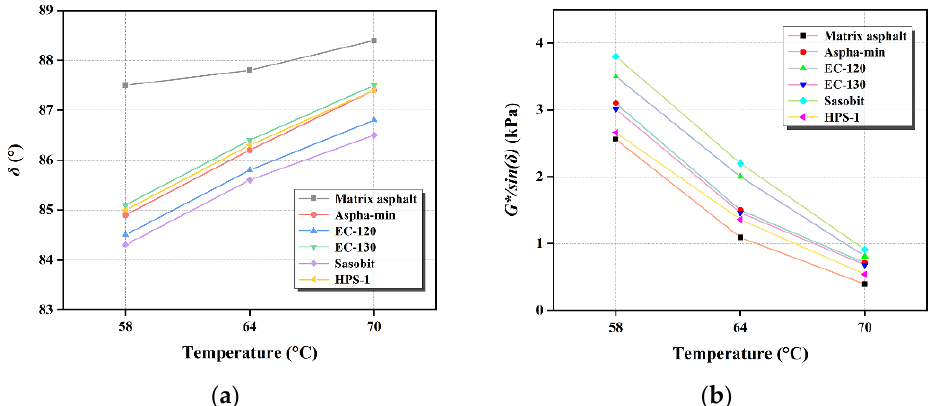
Figure 1. Test results of dynamic shear properties of original asphalt under different temperatures: ( a ) Phase angle; ( b ) G* /sin δ .